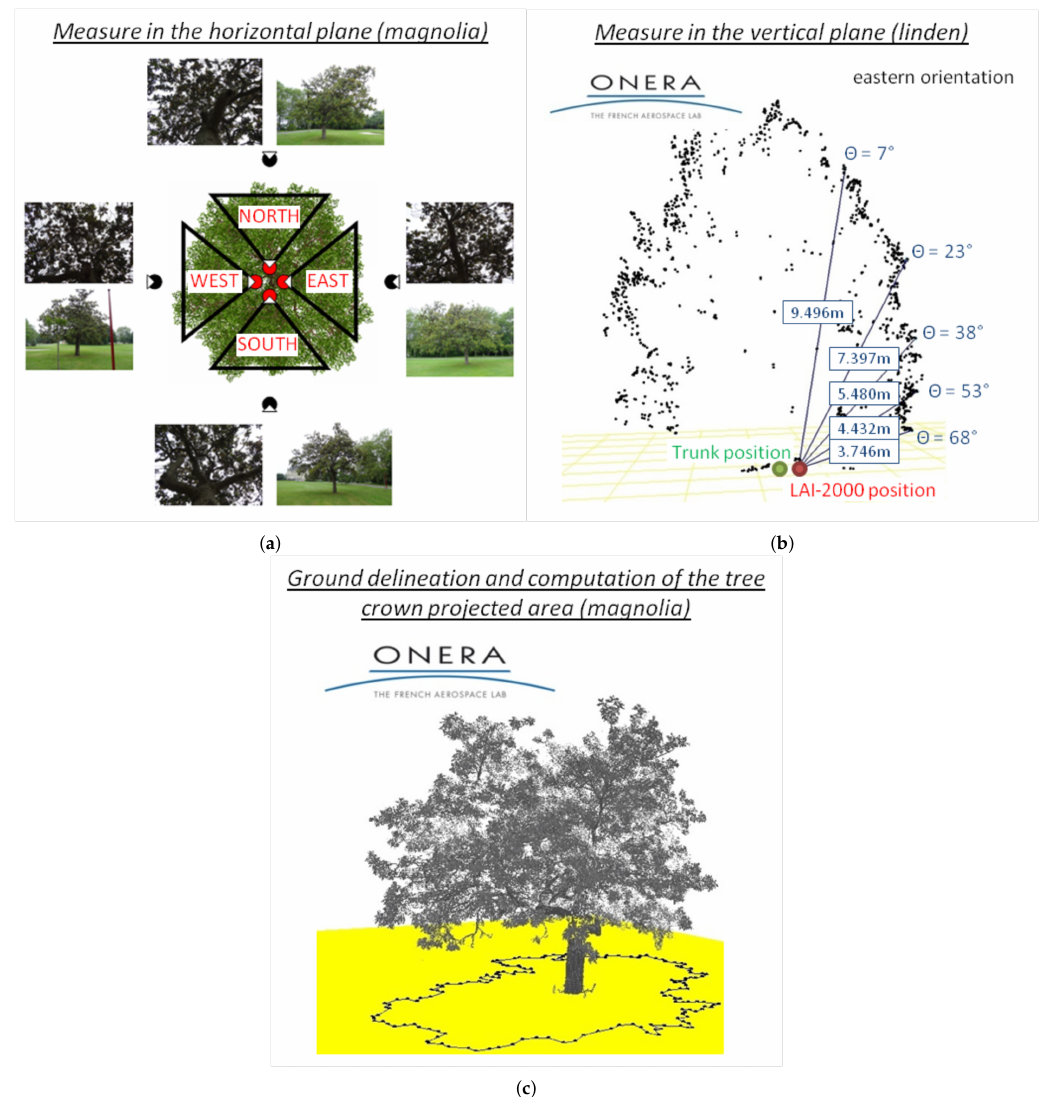
Figure 2. This is a wide figure. Figure A1. Illustrations of the LAI-2000 measuring principle and PAI retrieval for an isolated tree: ( a ) in the horizontal plane, measurements following the cardinal orientations with the device positions under and outside the tree crown (digital photos taken to show the crown heterogeneity), ( b ) in the vertical plane for each cardinal orientation, assessment of the sunlight path lengths inside the crown following the detector incident angles and with the help of the TLS 3D point cloud, and ( c ) the projection of the TLS 3D point clouds onto the mean ground plane defining a polyline whose the interior surface represents the tree crown projected